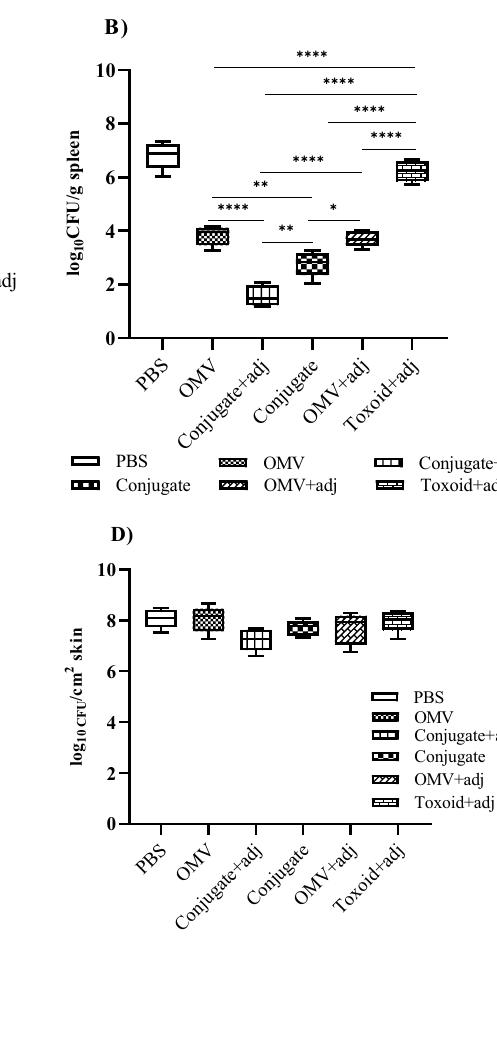
Figure 4. Determination of bacterial load in mice tissues. PA-OMVs-DT + adj reduced the bacterial loads against local and systemic dissemination of PAO1 in mice (n = 5) burn wound infection. Bacterial loads were determined by culturing the liver ( A ) and spleen ( B ), blood ( C ), and skin ( D ) homogenized samples at 24 h, and concentrations were presented in CFU per biopsy sample or gram tissue (CFU/g). Data were presented as box plots, with the median and interquartile ranges indicated. One-way ANOVA was used to compare values. The difference between immunized and control mice groups was indicated as a p value. * P < 0.05, ** P < 0.01, *** P < 0.001, and **** P < 0.0001 were considered statistically